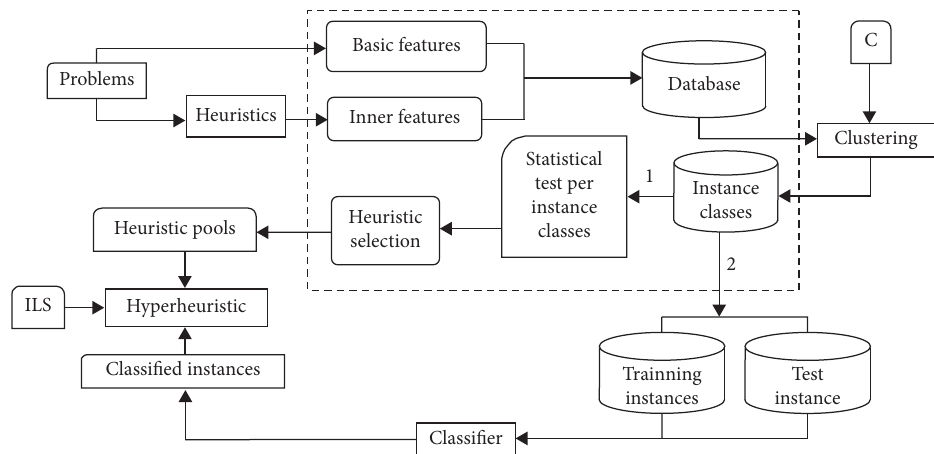
Figure 3: Methodology to determine the subset of heuristics for